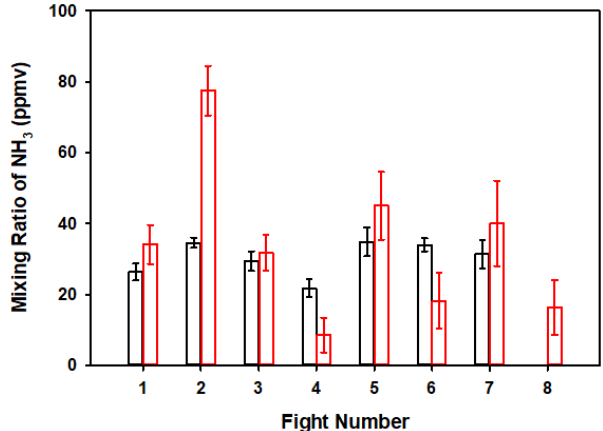
Figure 2. Mixing ratio of NH 3 ( g ) measured 1 m above the exhaust stack every 1 h (from 9:00 AM, UTC-5) by the UKySonde on September 11 ( black ) and 13 ( red ) of 2018.